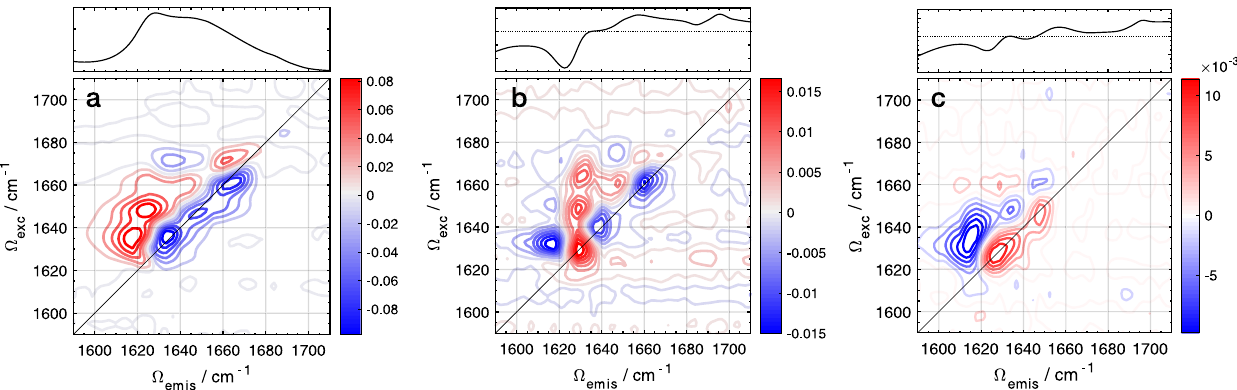
Fig. 4 2DIR spectroscopy of PsbS. 2DIR spectra of WT PsbS and the M2 (E176Q) mutant. a Equilibrium spectrum of WT PsbS in pD 7.5 buffer; upper panel: FTIR absorption spectrum of WT PsbS in pD 7.5 buffer; b pD 5.0 – 7.5 difference 2DIR of WT PsbS; upper panel: pD 5.0 – 7.5 difference FTIR of WT PsbS; c pD 5.0 – 7.5 difference 2DIR of the M2 (E176Q) mutant. upper panel: pD 5.0 – 7.5 difference FTIR of the M2 (E176Q) mutant. For the WT, 15000 scans were taken per sample at each pD and 6 protein samples were studied, of which one is shown. For the M2 mutant, 15000 scans were taken per sample at each pD and 3 protein samples were studied, of which one